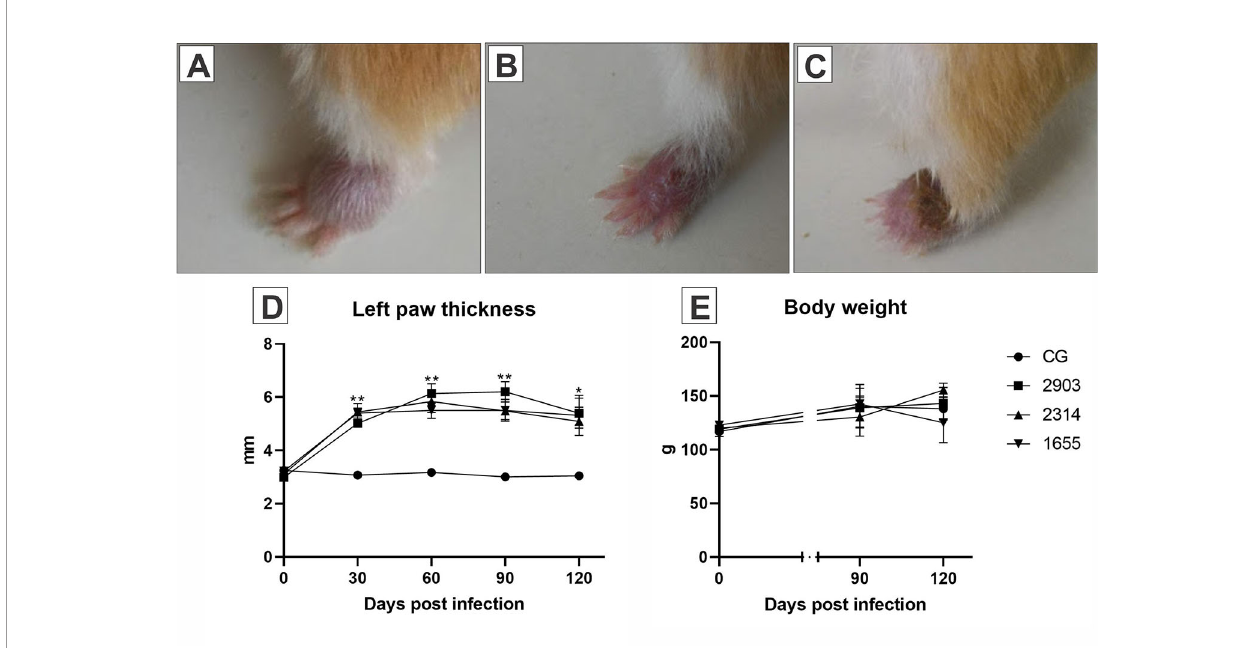
FIGURE 2 | Images (A – C) represent the evolution of the paw lesion after the infection by L. ( V.) braziliensis (MHOM/BR/2000/1655 strain): (A) initial edema, (B) initial lesion, (C) ulcerated lesion. (D) Represents the evaluation of the clinical course of lesions through the 120 days following the infections. The size of the lesions was measured with a digital pachymeter by evaluating the dorsal-ventral thickness of the infected paw (mm). *p < 0.05; **p < 0.001 when compared the infected groups to the respective control. (E) Demonstrates the body weight (g) of the hamsters before parasite inoculation and at 90- and 120-days post infection ( n = 4). CG, control group. 2903: group infected with MHOM/BR/1975/M2903. 2314: group infected with MHOM/BR/2003/2314. 1655: group infected with